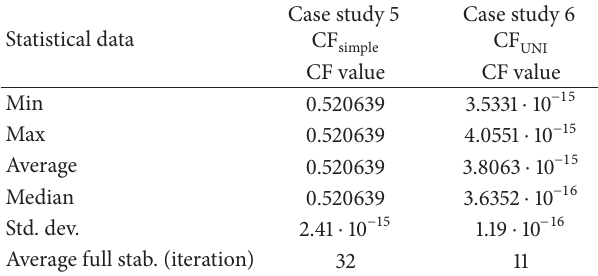
Table 8: Simple CF statistics: joined case studies 5 and 6, Lozi map as CPRNG/controlled